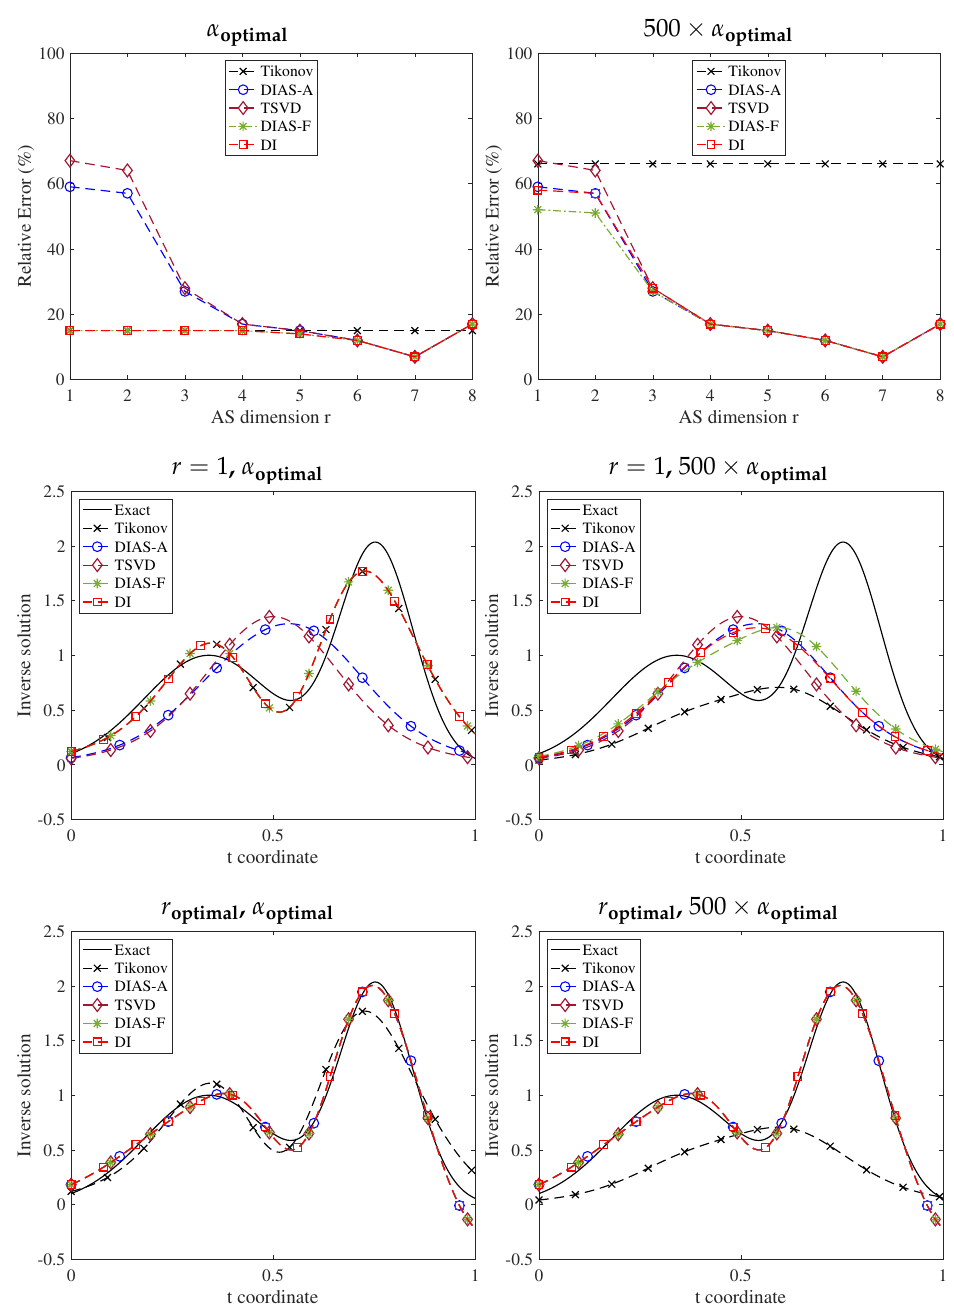
Figure 4. Shaw problem, α optimal = 1.35 × 10 − 2 . Comparison of different DIAS regularizations and Tikhonov regularization. Top row: relative errors in the inverse solutions for different regularization methods for two values of regularization parameter. Middle row: inverse solutions with DIAS regularizations with one-dimensional active subspace and Tikhonov regularization for two values of regularization parameter. Bottom row: inverse solutions with DIAS regularizations with the optimal dimension active subspace ( r optimal = 7) and Tikhonov regularization for two values of regularization